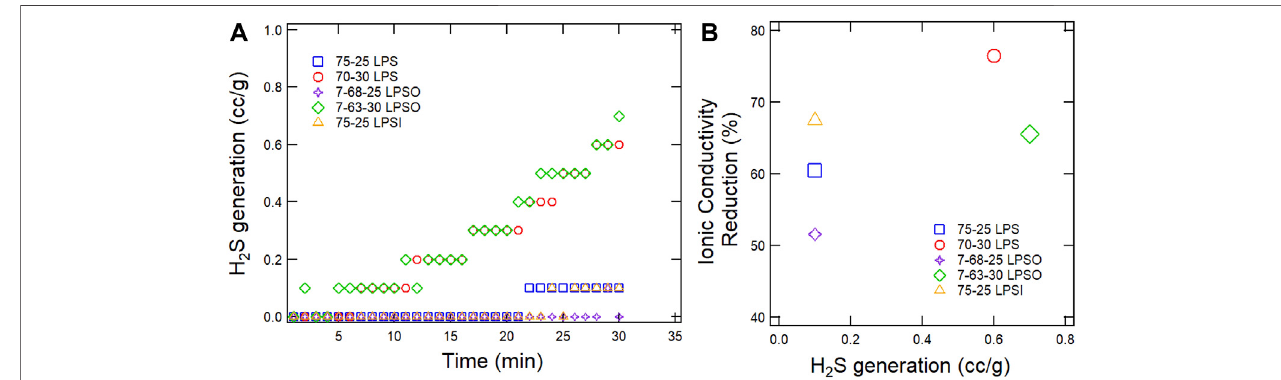
FIGURE 2 | A picture of the experimental setup used to expose sul fi de SSE powders to a dry room environment. The setup includes a 300L volume tabletop glovebox, a cartridge-based desiccant system, a microcontroller system to control the moisture setpoint, a personal H 2 S detector, and a fan to continuously mix the glovebox